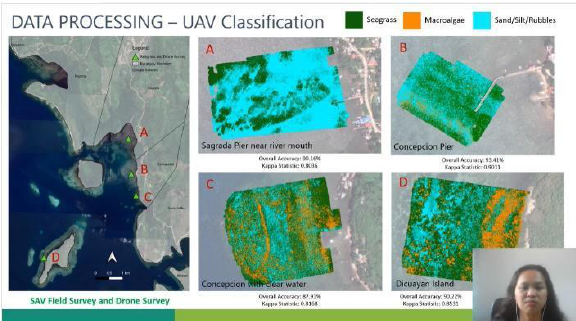
Figure 11. One of the presenters in the virtual edition of the ISPRS Congress under the Youth Forum track, Ms Ayin